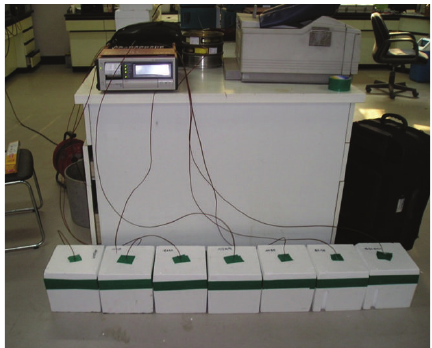
Figure 6: Simple hydration heat test.